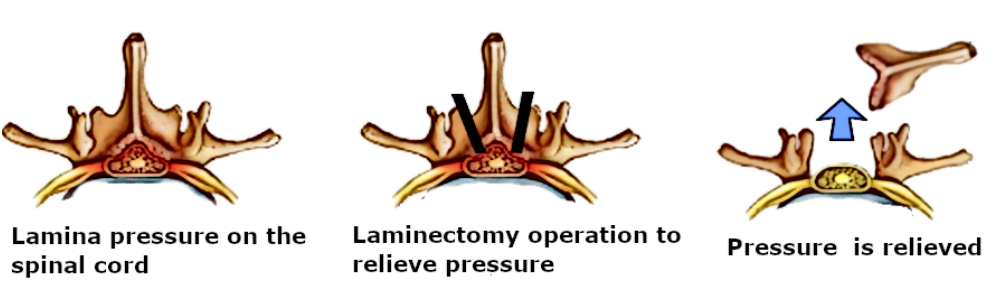
Figure 3. The laminectomy